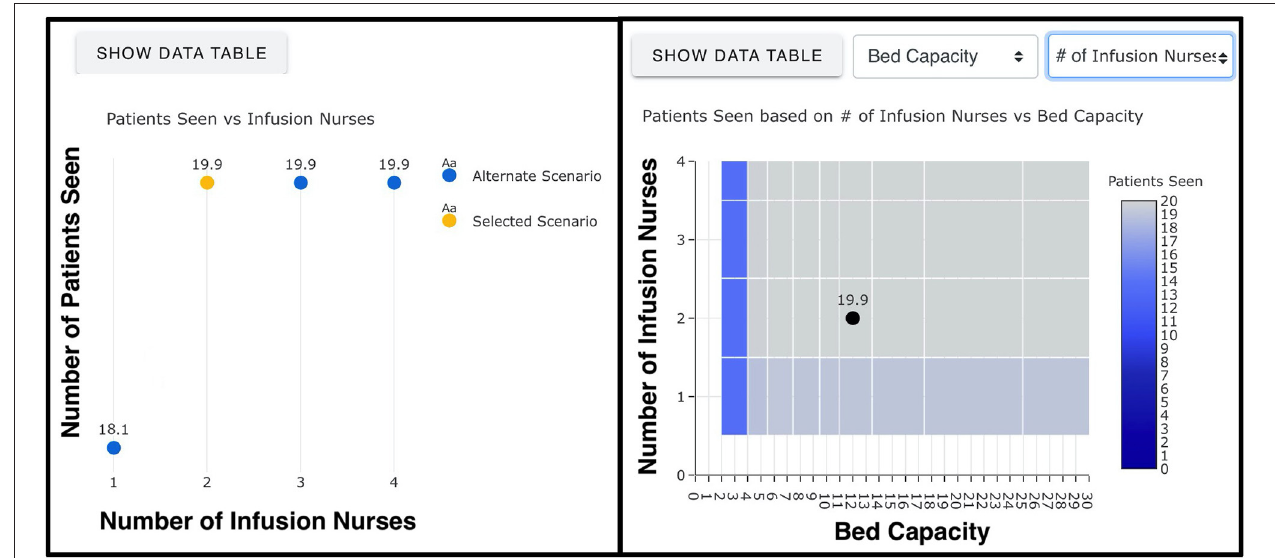
FIGURE 3 | Graphs generated by the web-based mAb infusion process calculator (https://www.phe.gov/Preparedness/Pages/mabcalctool.aspx).